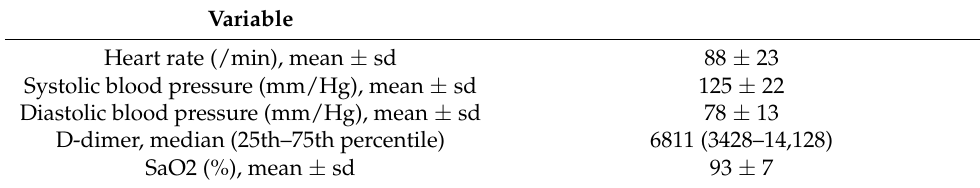
Table 4. Main parameters at the time of pulmonary embolism diagnosis.